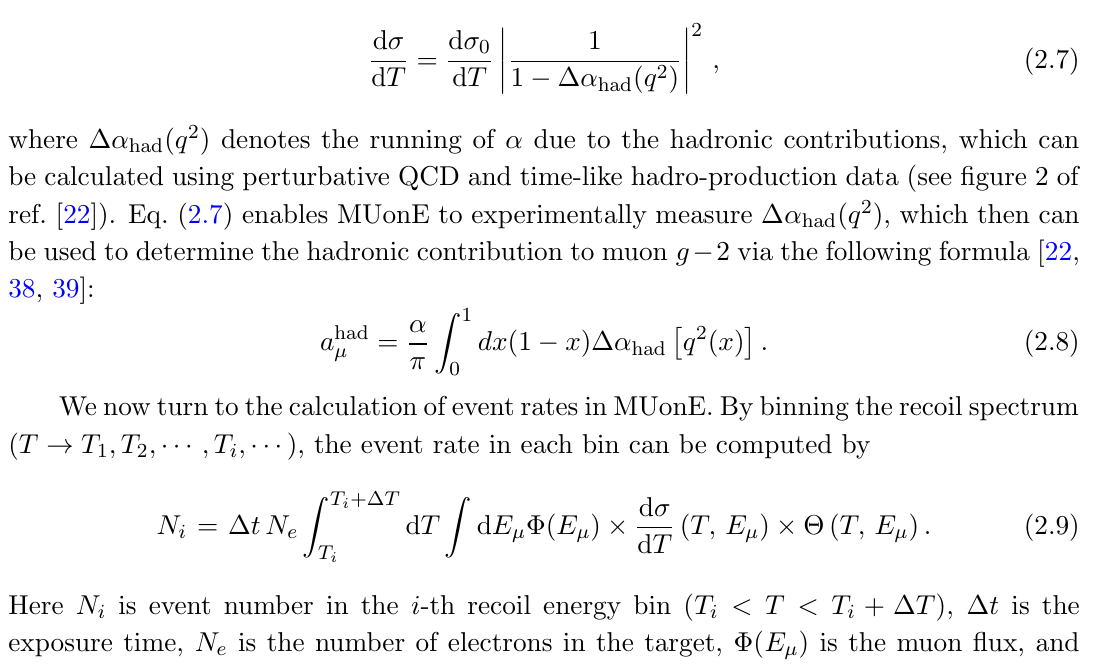
Figure 1 . Feynman diagrams for the SM processes that contribute to (cid:22) { e scattering in MUonE. Compared to the dominant contribution from the SM-a diagram, the relative sizes of the SM-b and SM-c contributions (including interference) are about 0 : 001% and 0 : 2% respectively at the maximum of q 2 in